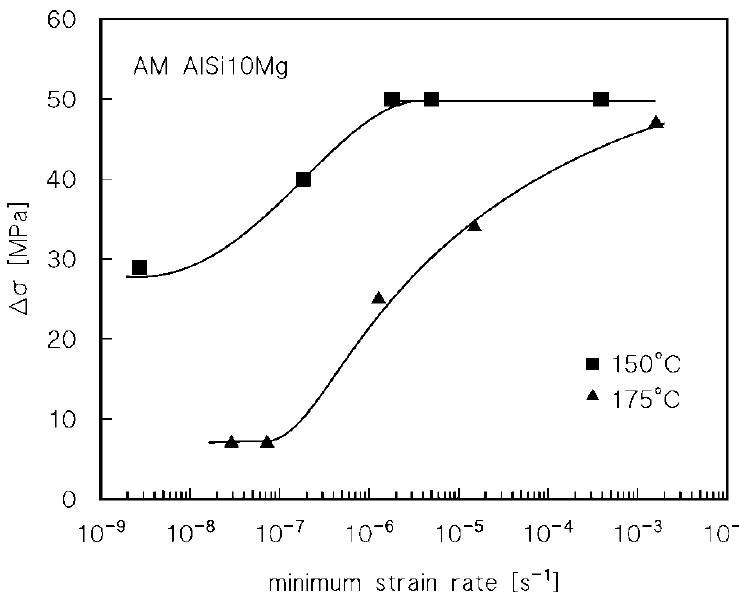
Figure 6. Δ σ as a function of the minimum creep rate for 150 °C and 175 °C. Figure 6. ∆ σ as a function of the minimum creep rate for 150 ◦ C and 175 ◦